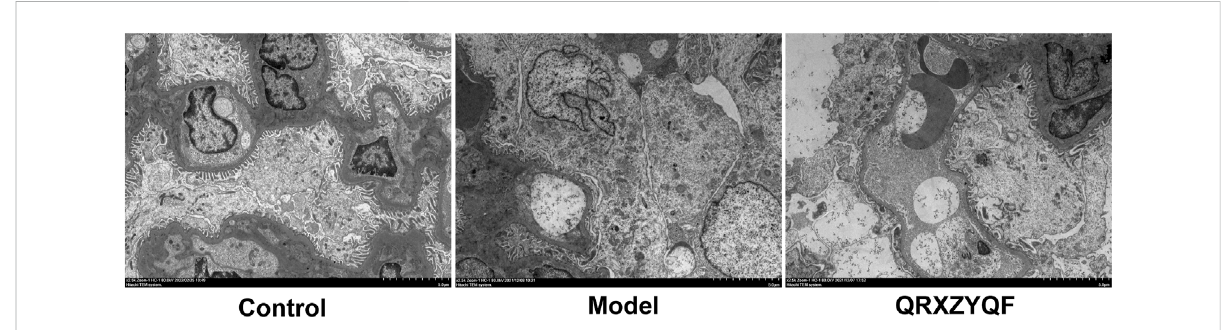
FIGURE 5 RepresentativeTEMimagesshowingthethickeningofglomerularbasementmembrane,fusionsordisappearanceoffootprocessofpodocytes (scale bar: 5 μ m).